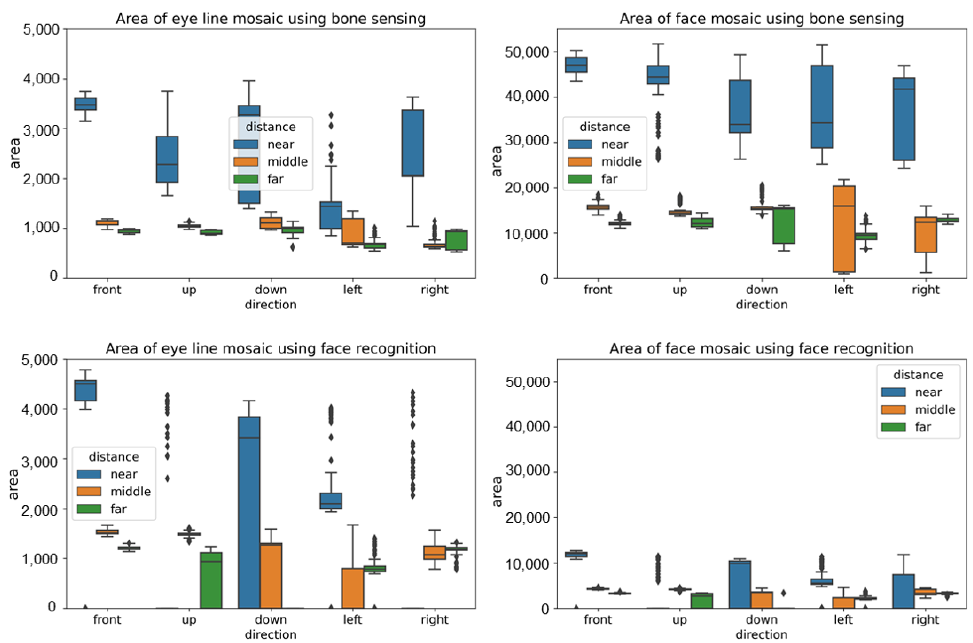
Figure 15. Comparing area of masking face with different directions and